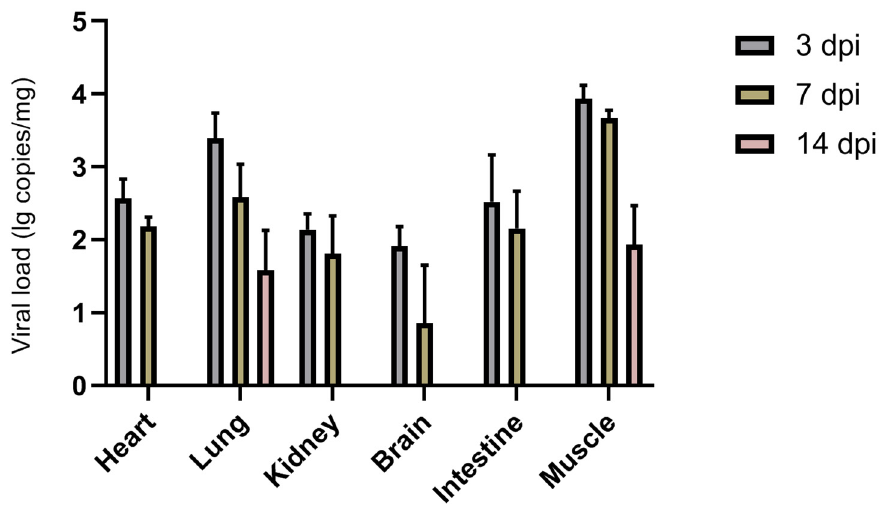
Figure 3. Replication kinetics of HB19-1-infected mice. Detection and quantification of the BEV HB19-1 strain in ICR mice. Heart, liver, spleen, lungs, kidneys, brain, intestines, and muscle tissues of the BEV HB19-1-infected mice were obtained in triplicate. The total cellular RNA was extracted